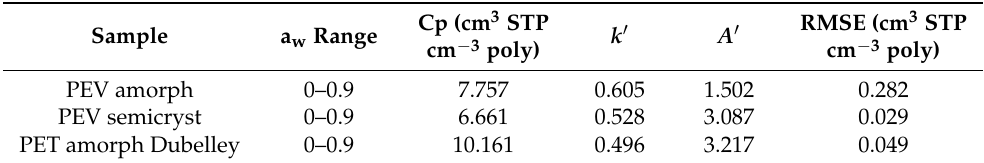
Table 2. Sorption parameters Cp , k (cid:48) , A (cid:48) of amorphous and semicrystalline PEV and amorphous PET according to the new dual mode sorption